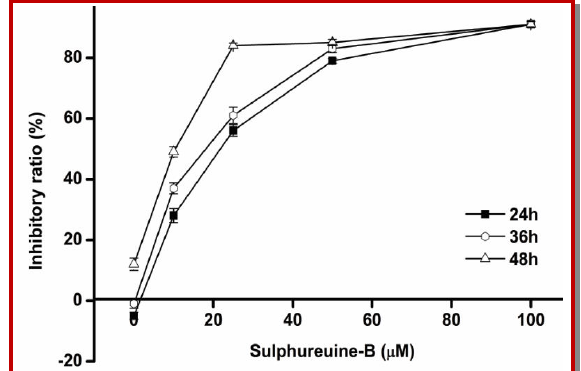
Figure 2: Inhibitory effect of sulphureuine B against U-87MG cells with various concentrations of 5, 10, 25, 50, and 100 µM for 24, 36 and 48 hours